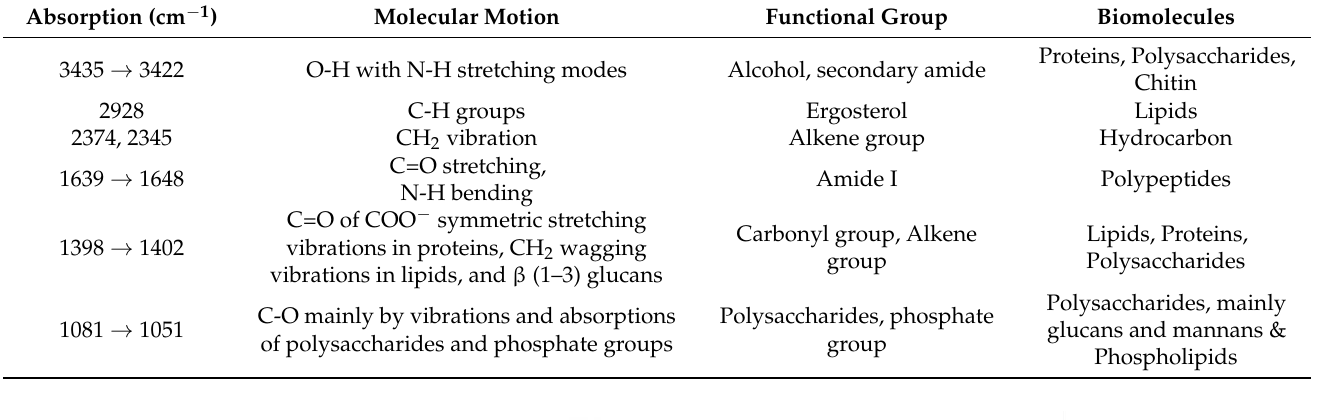
Table 1. Possible involvement of functional groups in the surface binding of ZnO NPs on the yeast cell surface.